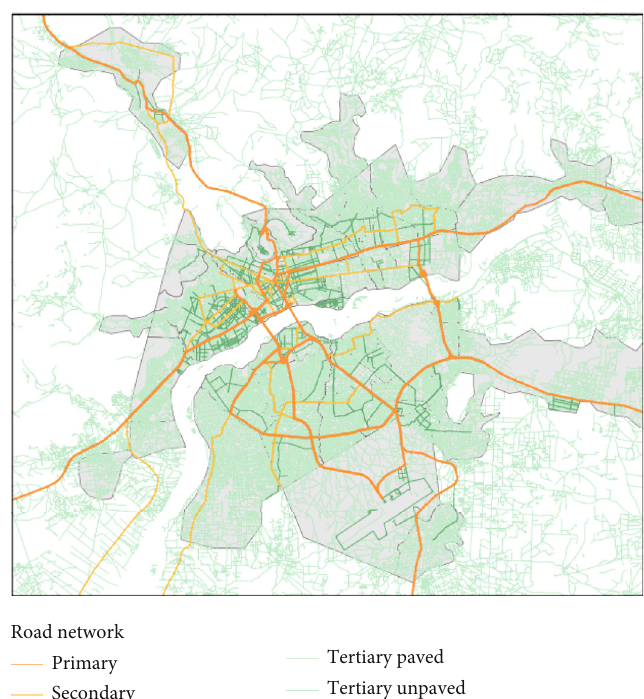
Figure 4: Road network of the city of Bamako. Source: [39].